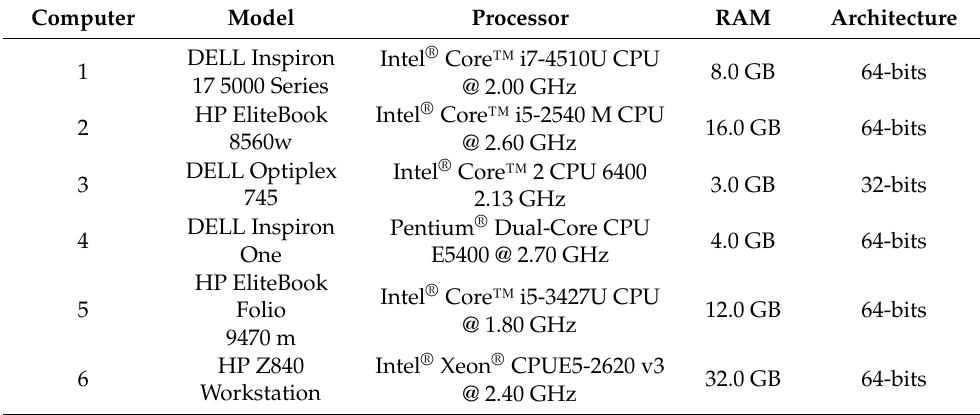
Table A1. Characteristics of the computers used in the benchmarks to quantify the different compu- tational